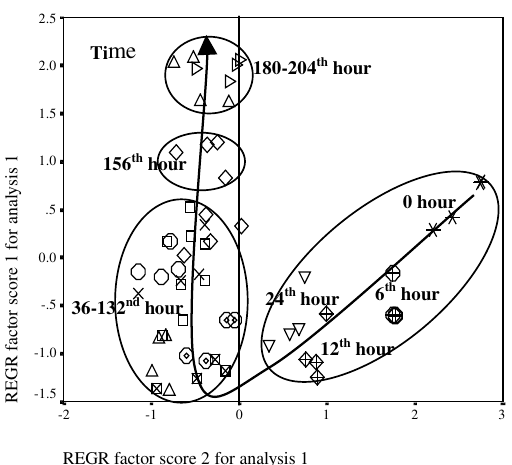
Fig.7. Score plot of a principle component analysis.